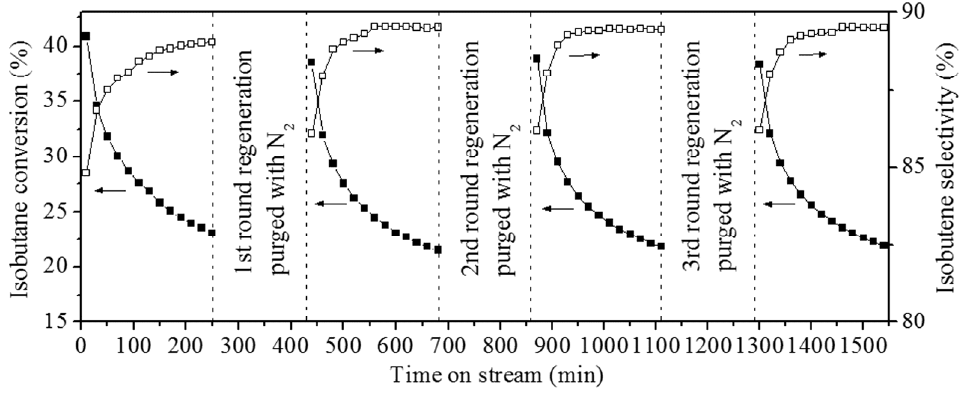
Figure 11. Regeneration of the 7% V/SBA catalyst at 550 °C. ( ) conversion, ( ) selectivity.